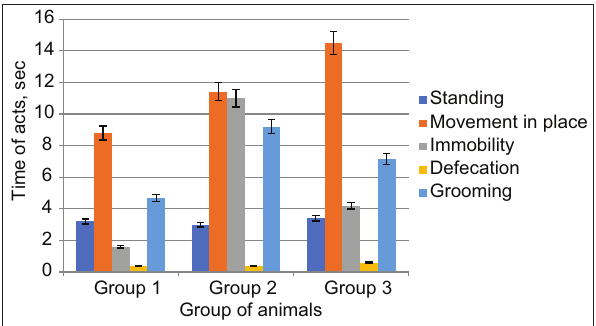
Figure-3: Changes in the past squares and the number of acts in the past squares when exposed from the Samsung Galaxy J1 Mini and Xiaomi Redmi S2 phones.